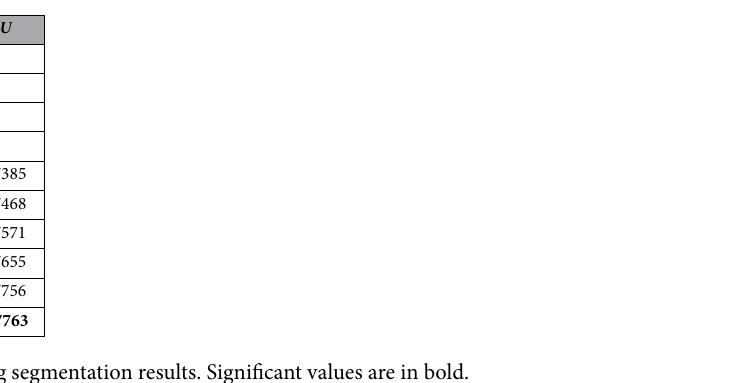
Table 3. Evaluation of building segmentation results. Significant values are in